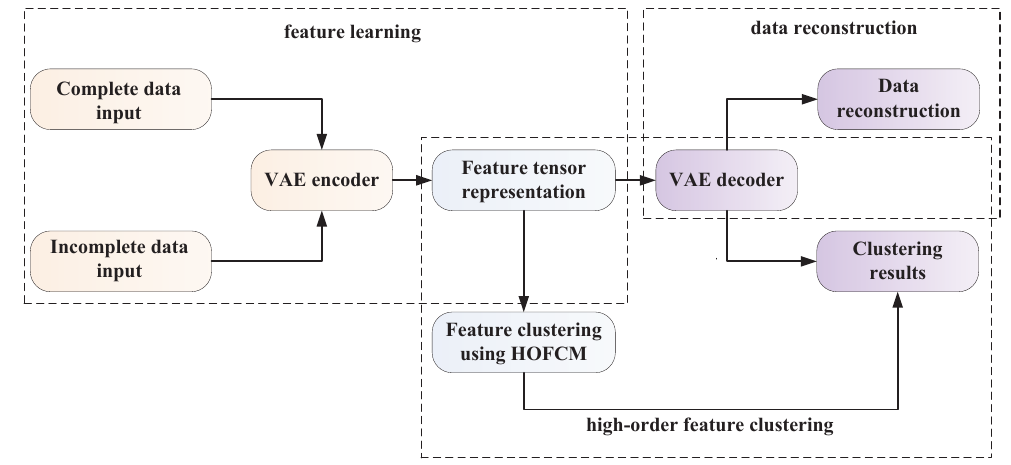
Figure 1. Architecture of the proposed method.